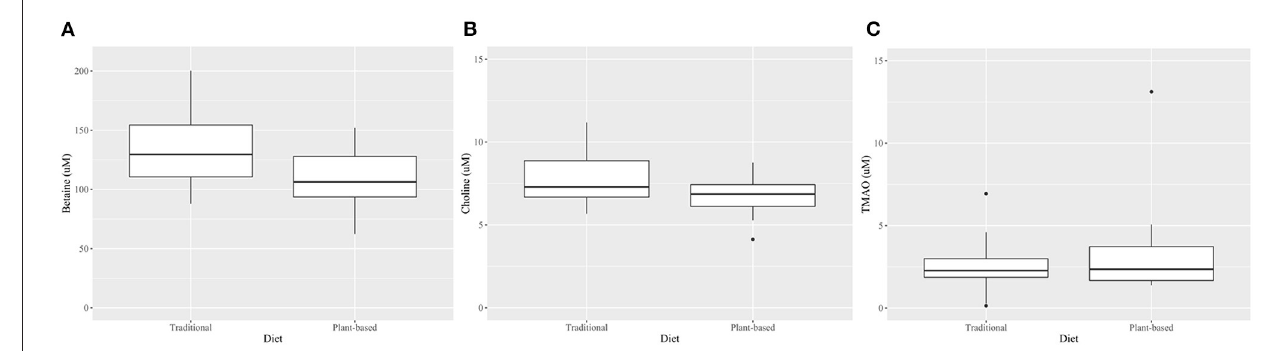
† FIGURE 3 | Boxplots comparing plasma betaine* (A) , choline* (B) , and TMAO (C) concentrations after 4 weeks on a traditional diet (TD) or a plant-based diet (PBD) in 16 healthy dogs. Betaine ( P = 0.002) and choline ( P = 0.03) were lower in dogs after 4 weeks on a PBD compared to a TD. There was no statistical evidence of difference for TMAO ( P = 0.71). *Mean (standard deviation), paired t -test. † -Median (interquartile range), Wilcoxon Signed Rank test.